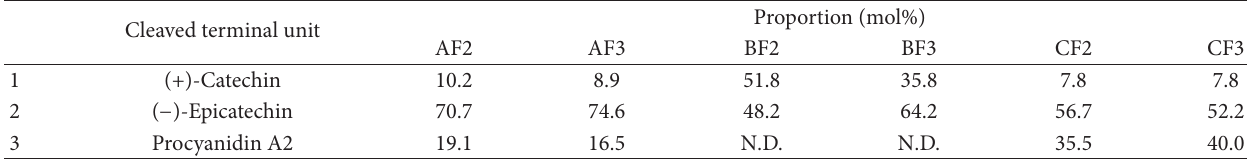
T 2: Proportions of terminal units in highly polymeric proanthocyanidins from seed shells of Japanese horse chestnut, blueberry, and cranberry as determined by UPLC-ESI/MS of the thiolytic products.